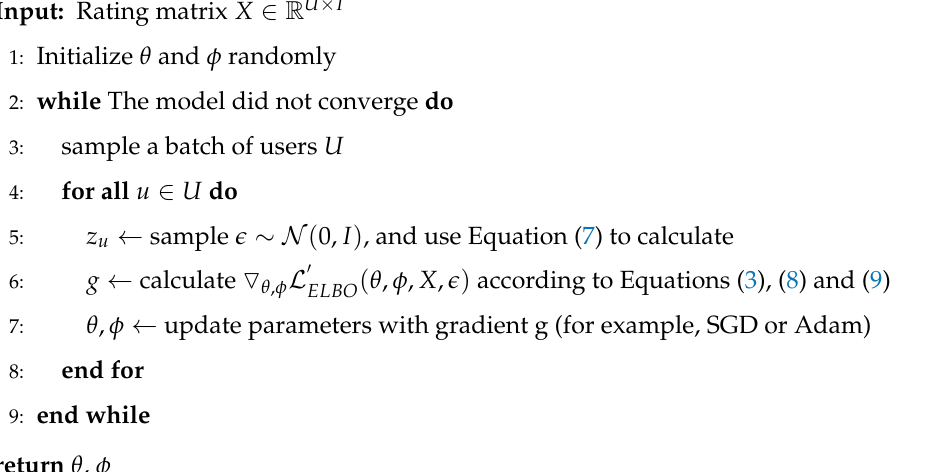
Algorithm 1 GVAE-CF uses stochastic gradient descent algorithm to optimize the